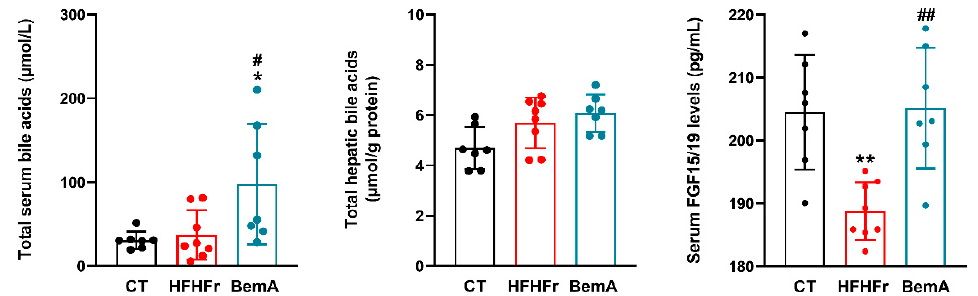
Figure 5. Effect of HFHFr supplementation and BemA treatment on Sprague-Dawley female rats’ serum and liver bile acid concentrations and serum FGF15/19 levels. Bar plots show concentrations as mean ± SD, as well as individual values from 7–8 samples, corresponding to the three experimental groups studied: CT (control), HFHFr (high-fat high-fructose), and BemA (HFHFr treated with BemA) female Sprague-Dawley rats. * p < 0.05, ** p < 0.01 vs. CT; # p < 0.05, ## p < 0.01 vs. HFHFr.